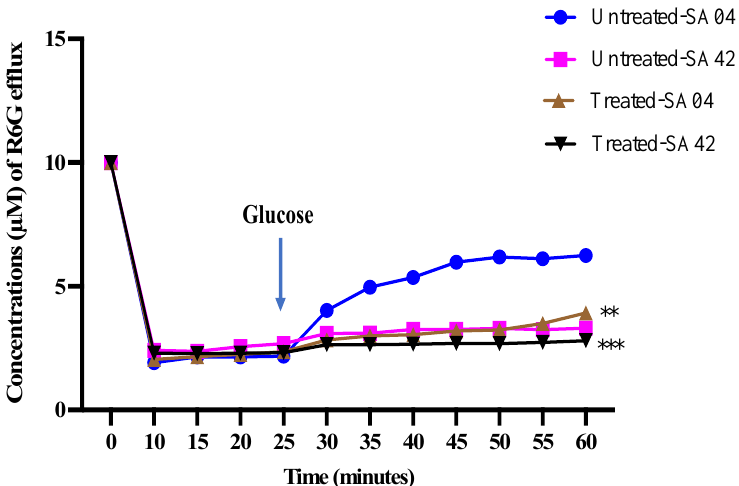
Figure 4. Effect of HNP on the efflux activity of different C. albicans strains. The figure represents the impact of HNP against efflux pumps in FLC-sensitive ( C. albicans SA42) and resistant ( C. albicans SA04) strains of C. albicans . The statistical difference between test was evaluated relative to the negative control using Student’s unpaired two-tailed t -tests (** p value = 0.005; *** p value = 0.0001).